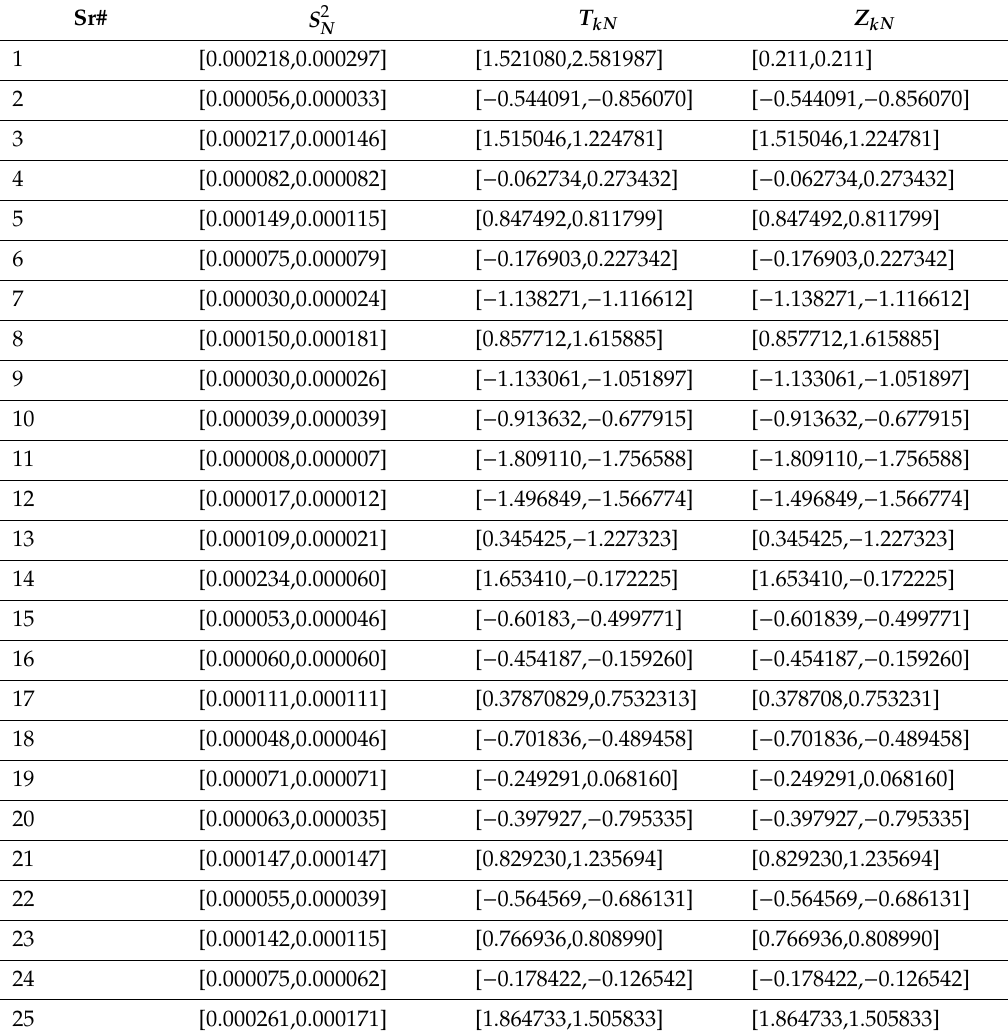
Table 10. The values of statistic for the proposed